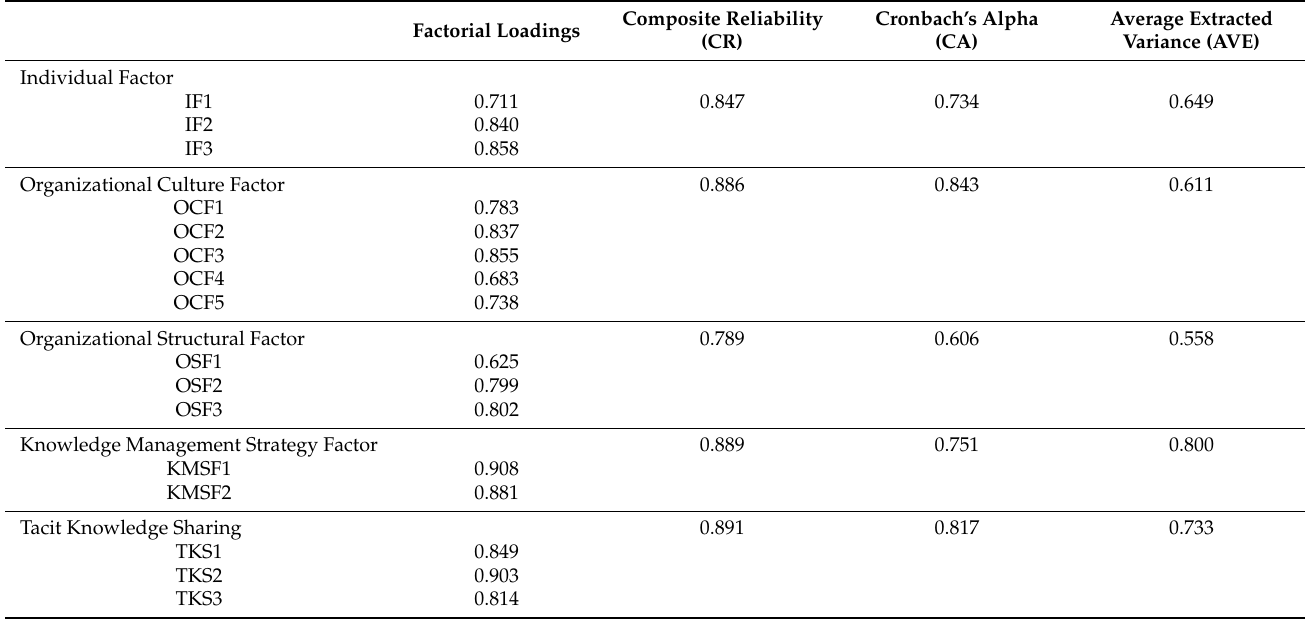
Table 2. Construct